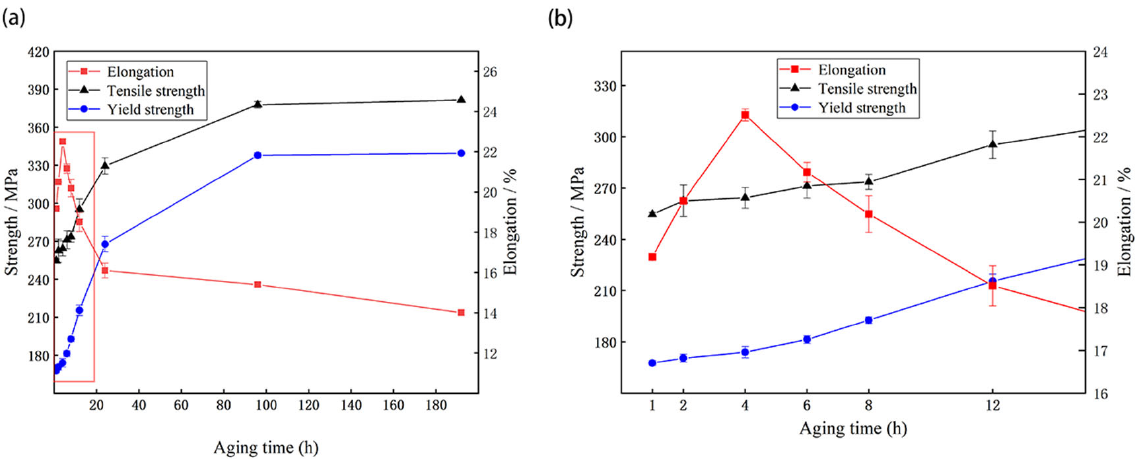
Figure 7. Mechanical performance of 7005 aluminum alloy plates aged at 120 °C for different durations. Note: ( b ) is a partial enlargement of the red box in ( a ).